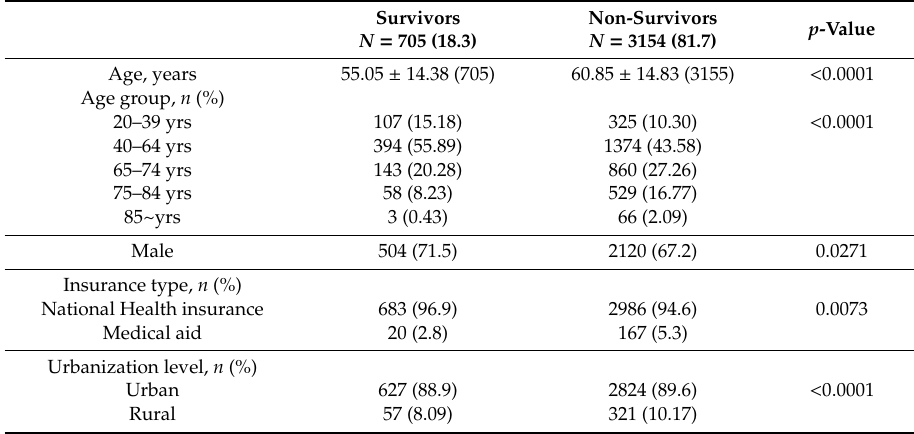
Table A2. The comparison of demographic, hospital, and medical factors between one-year survivors and non-survivors of ECMO supported patients with cardiac arrest before PS matching